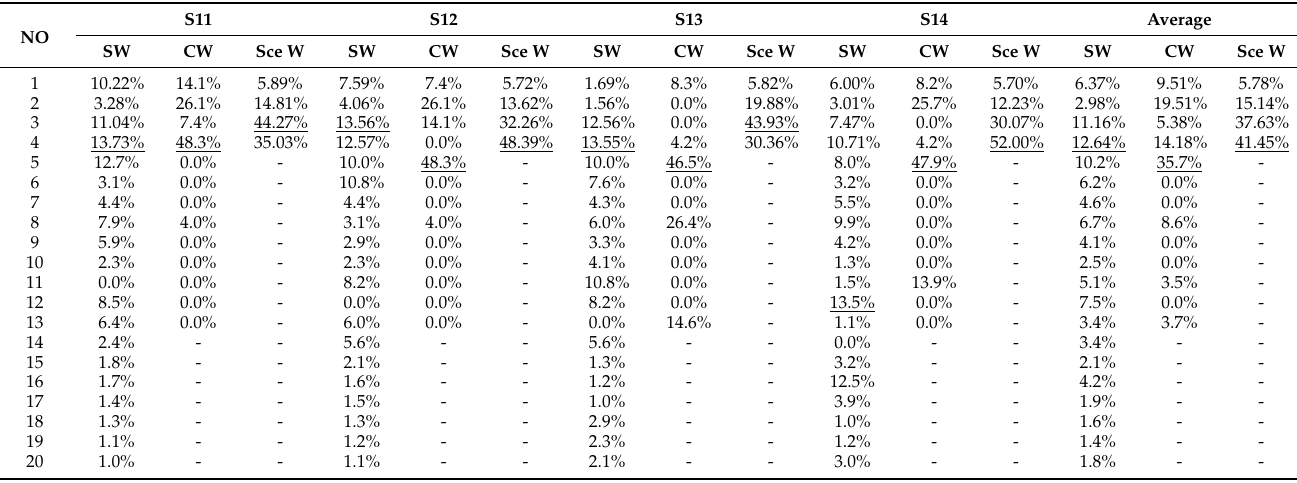
Table A4. Results of pairwise comparison of the Saaty scale (from − 9 to 9) for the Banjarnegara group.